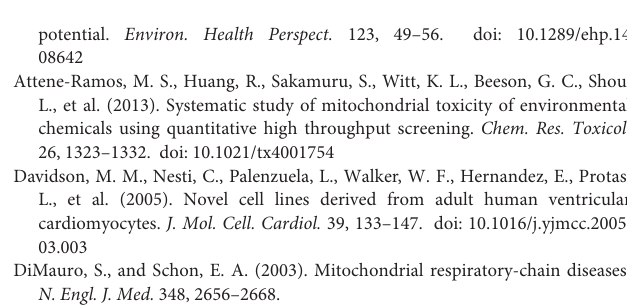
FIGURE S1 | Characterization of quantity of proteomic profiling results. (A) Correlation of coefficient of variation in set 1 and set 2 samples. (B) Coefficient of variation distribution of six different groups and a mixture of all 18 samples. FIGURE S2 | Overview of up/down-regulated protein in different treatment groups. (A) The number of significantly changed proteins when applying the cutoff of power > 0.8. (B) The number of significantly changed proteins when applying the cutoff of power > 0.8 and threshold ± 0.15-fold. TABLE S1 | Compiled information for protein identifications. Accession number, statistical information, sequence coverage and protein annotation information are included. TABLE S2 | Pathway annotation in Poochon database and calculation of coverage percentage. TABLE S3 | The list of 77 non-mitochondrial proteins which were significantly ( p < 0.05, n = 3) up/down-regulated 0.15-fold in at least one compound treatment across six groups of 18 samples. TABLE S4 | The list of 550 non-mitochondrial proteins which were significantly ( p < 0.05, n = 3) up/down-regulated 0.15-fold in at least one compound treatment across six groups of 18 samples. TABLE S5 | The expression level of proteins mentioned in the text in different treatment